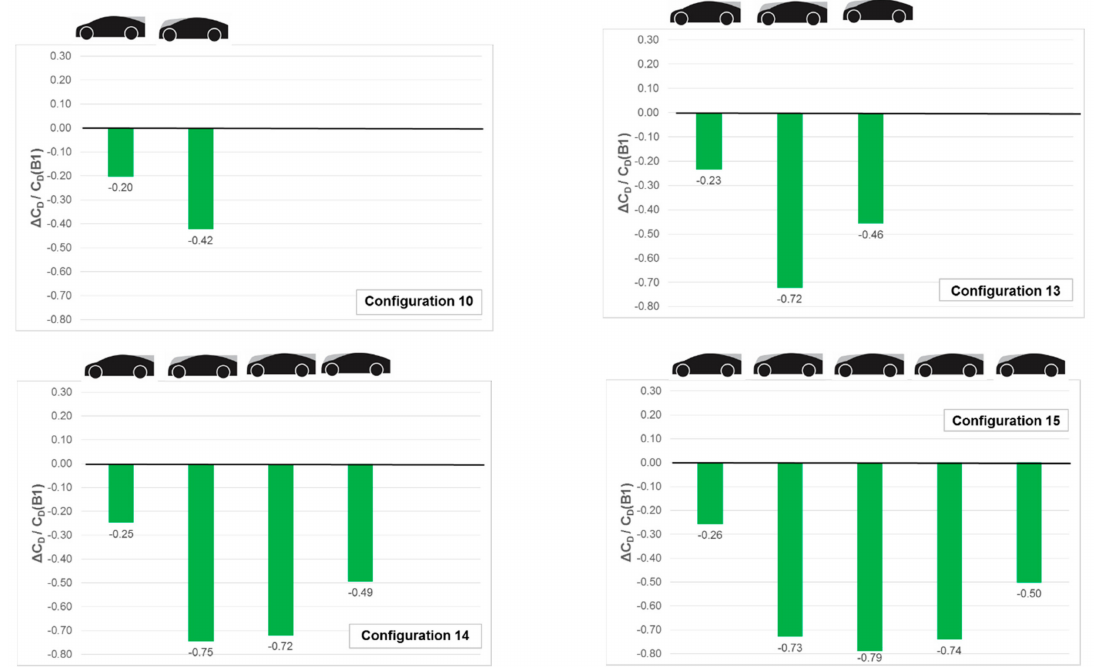
Figure 9. Change in Drag Coefficient ∆ CD between that of the baseline Resnick model and selected versions for 2, 3, 4, and 5-vehicle platoons. Configuration 10 comprising B2 and B4 styles. Configurations 13, 14 and 15 comprising B2, B3, and B4